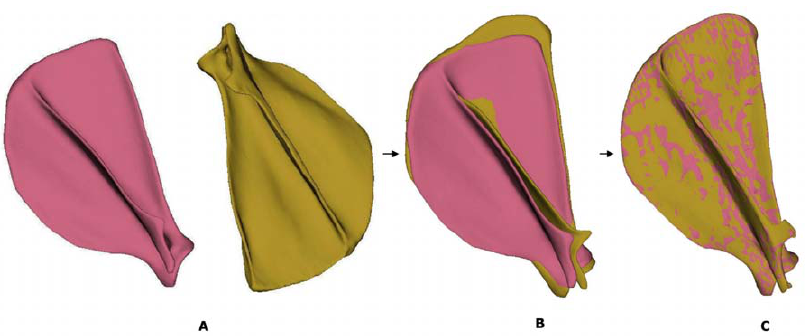
Figure 6. Establishing correspondences between reference (in pink) and target shape (in yellow). A: original position; B: align reference and target shapes; C: reference shape deformed to target shape.